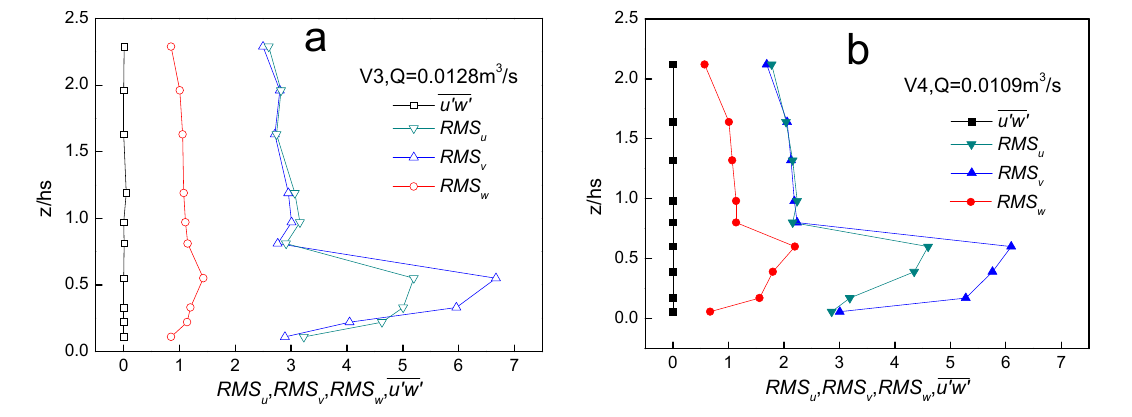
Figure 7. Turbulence intensities and Reynolds stress against relative depth ratio of vertical distance from bed z to stem height h : ( a ) represents V3 pattern and Q = 0.0128 m 3 /s; s ( b ) represents V4 pattern and Q = 0.0109 m 3